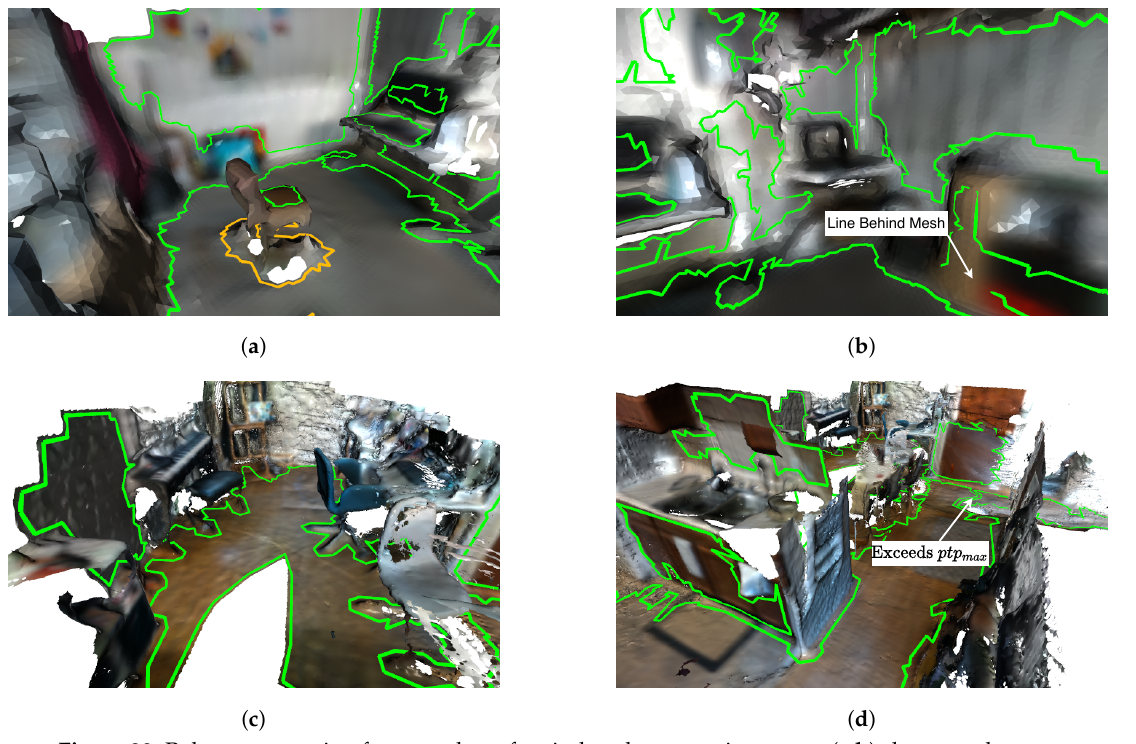
Figure 20. Polygon extraction from meshes of an indoor home environment. ( a , b ) show results on a basement mesh which has a smoother approximation and less noise; ( c , d ) show results on a significantly larger, denser, and nosier mesh of the main